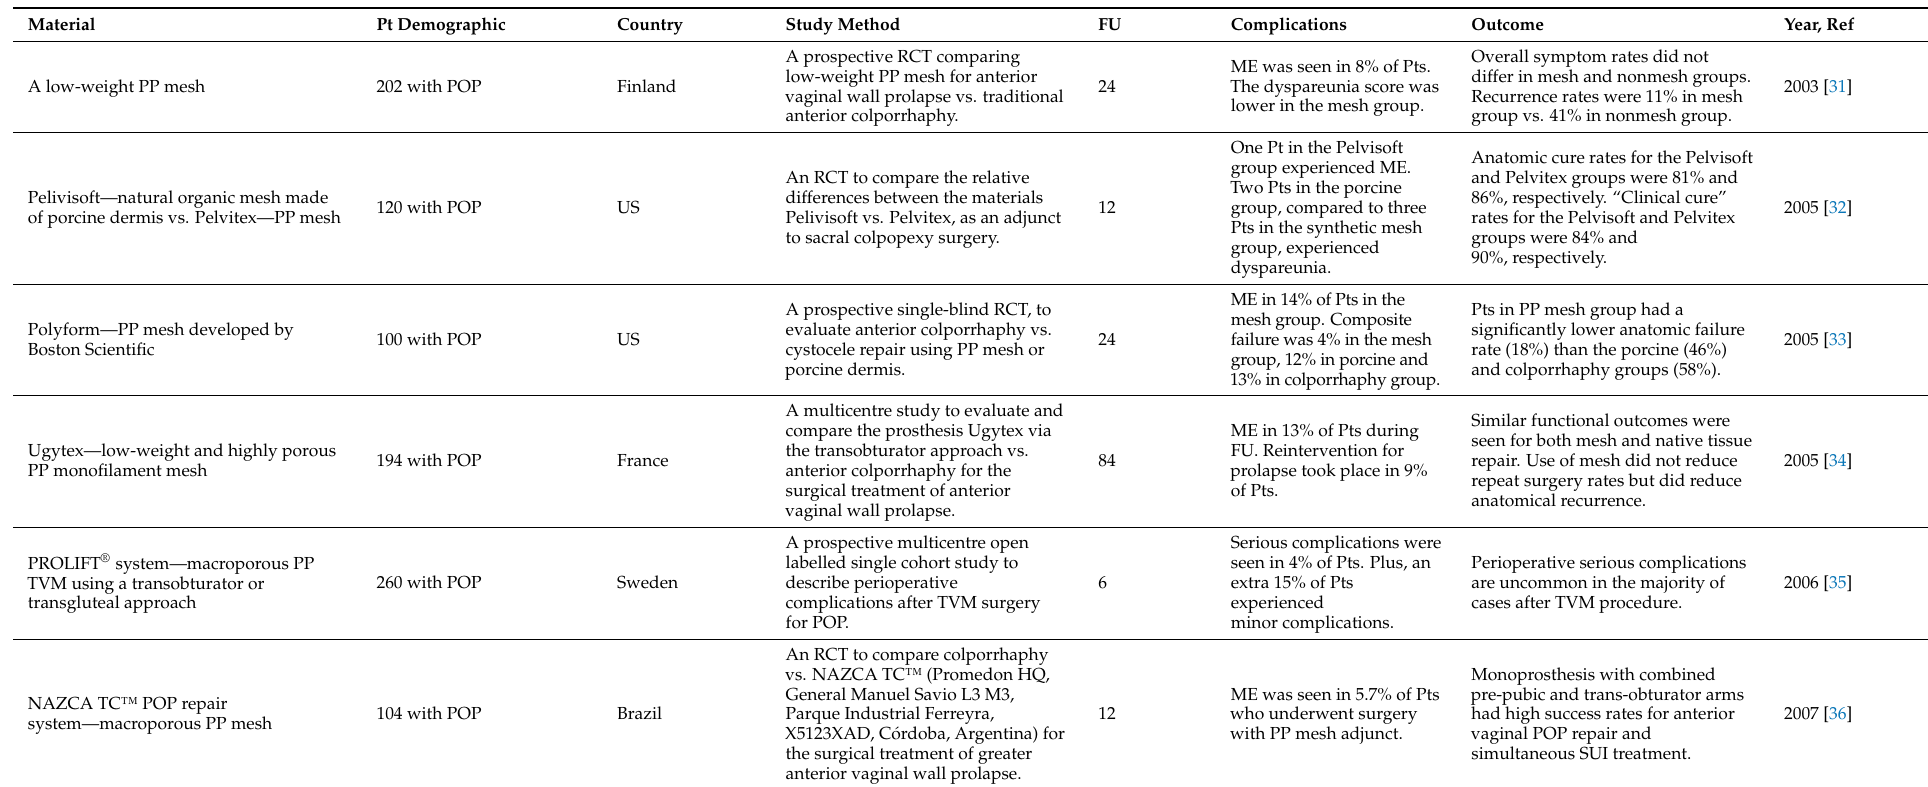
Table 3. Summary of Clinical Trials, www.clinicaltrials.gov (accessed on 22 February 2023), of polypropylene (PP) vaginal mesh. Keys: FU, follow up in month;